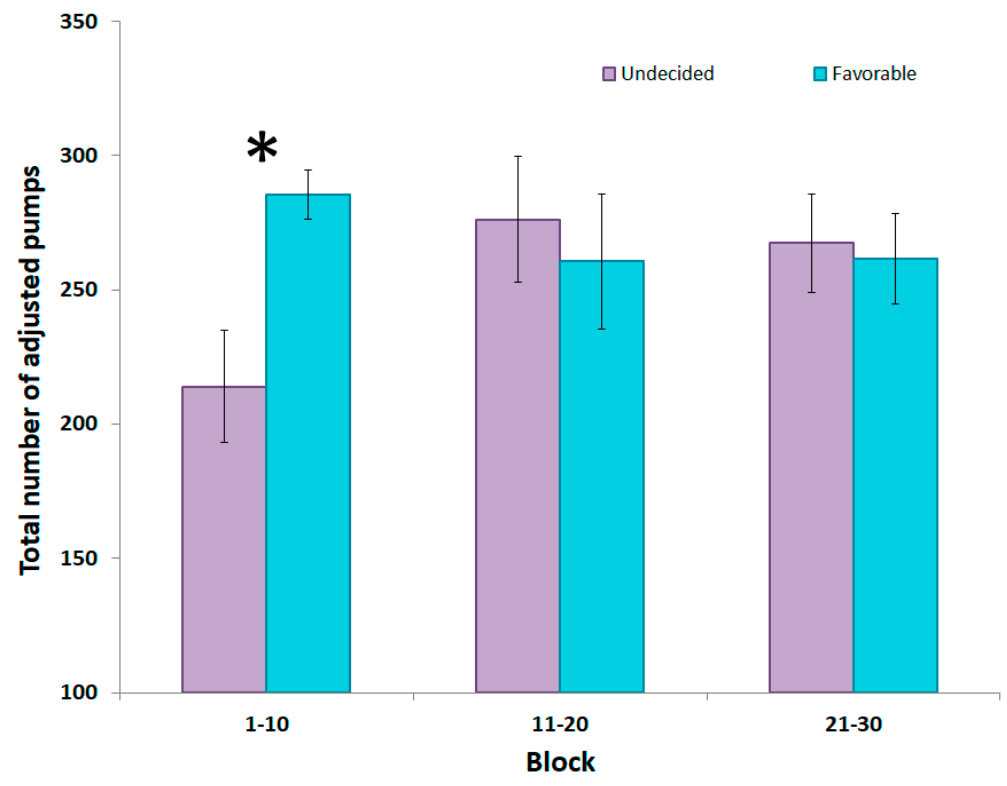
Figure 2. Mean total number of adjusted pumps across the three blocks of the Balloon Analog Risk Task (BART) in the undecided and favorable groups. A significant difference was found between the groups in the first 10 trials. * p < 0.05